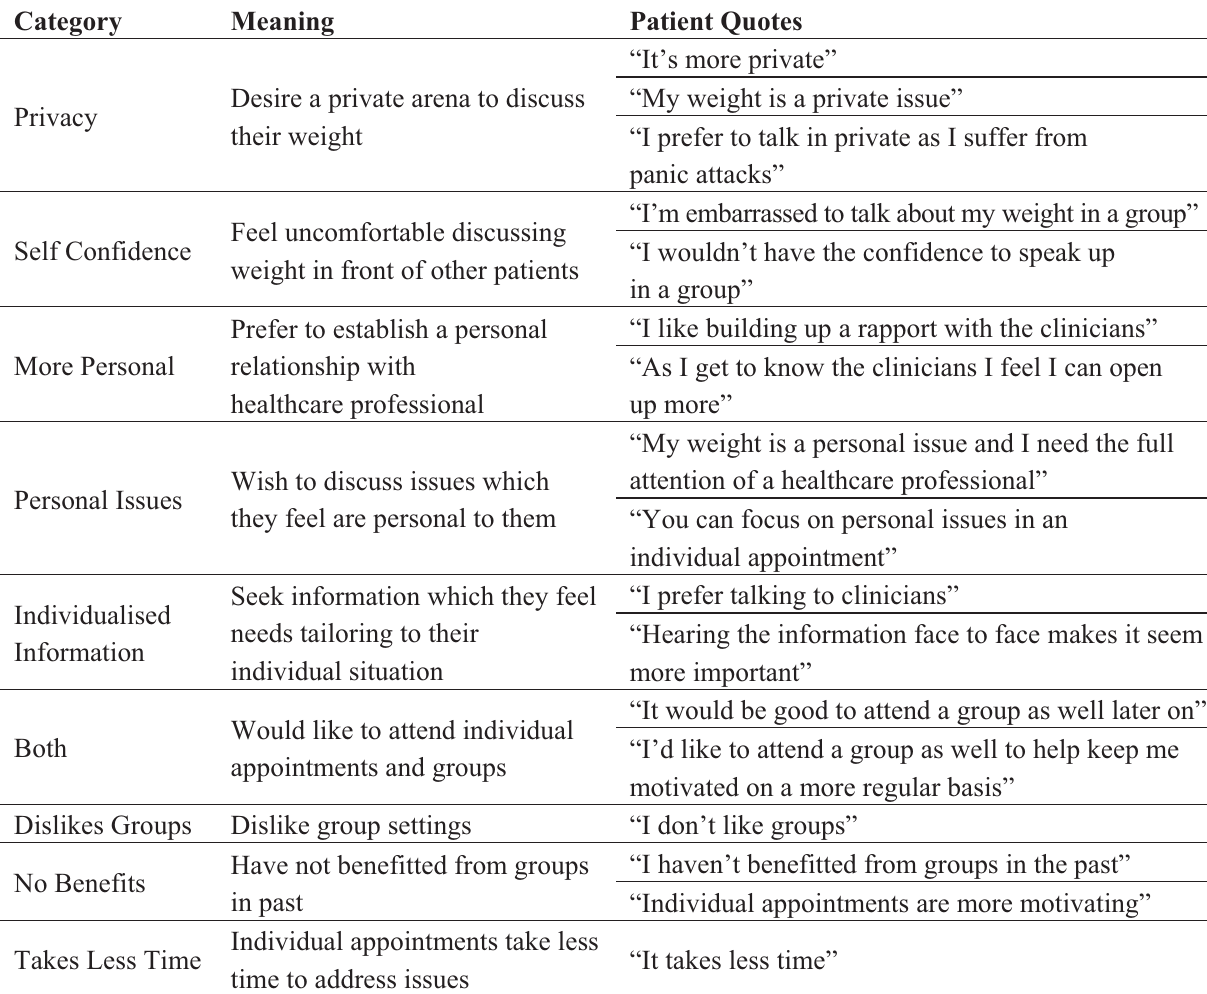
Table 6. Explanation of reasons respondents gave for preferring individual